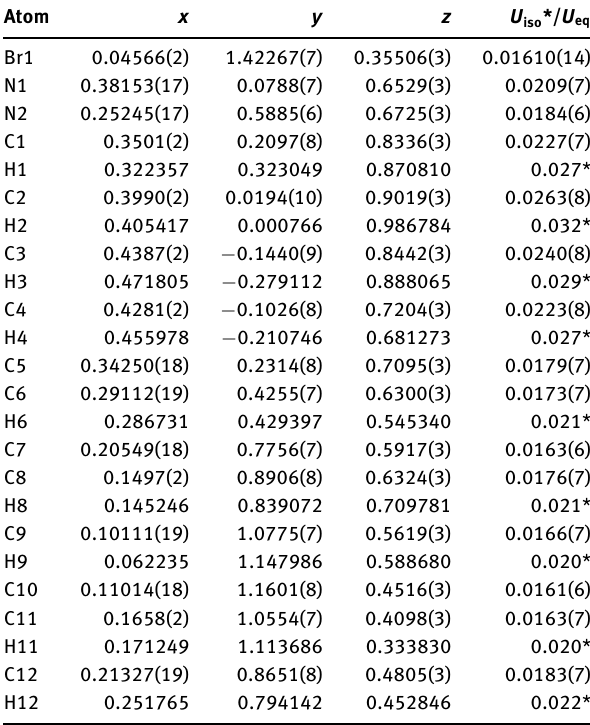
Table 2: Fractional atomic coordinates and isotropic or equivalent isotropic displacement parameters (Å 2